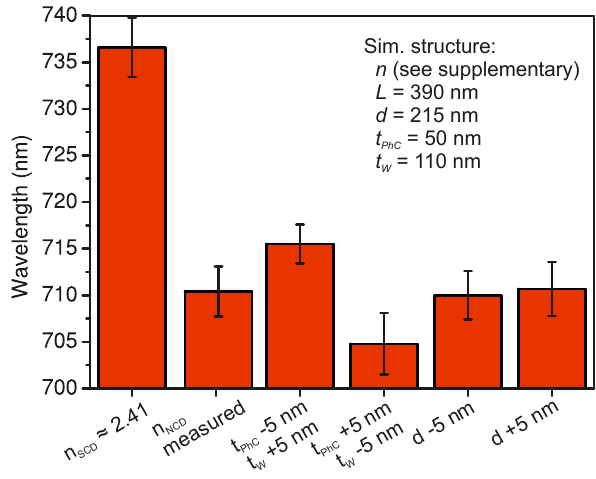
Figure 2: Simulated spectral position of the TE 0 leaky mode for normal incidence and its dependence on the refractive index of the layer (refractive index of single-crystal diamond [SCD] and nano- crystalline diamond [NCD], for details on the refractive index, see Figure S1 in the Supplementary material), on the depth of etching (shallower etching increases t w and reduces t PhC ) and on the diam- eter of columns ( d ). The error bars correspond to the spectral full width at half maximum (FWHM) of the leaky